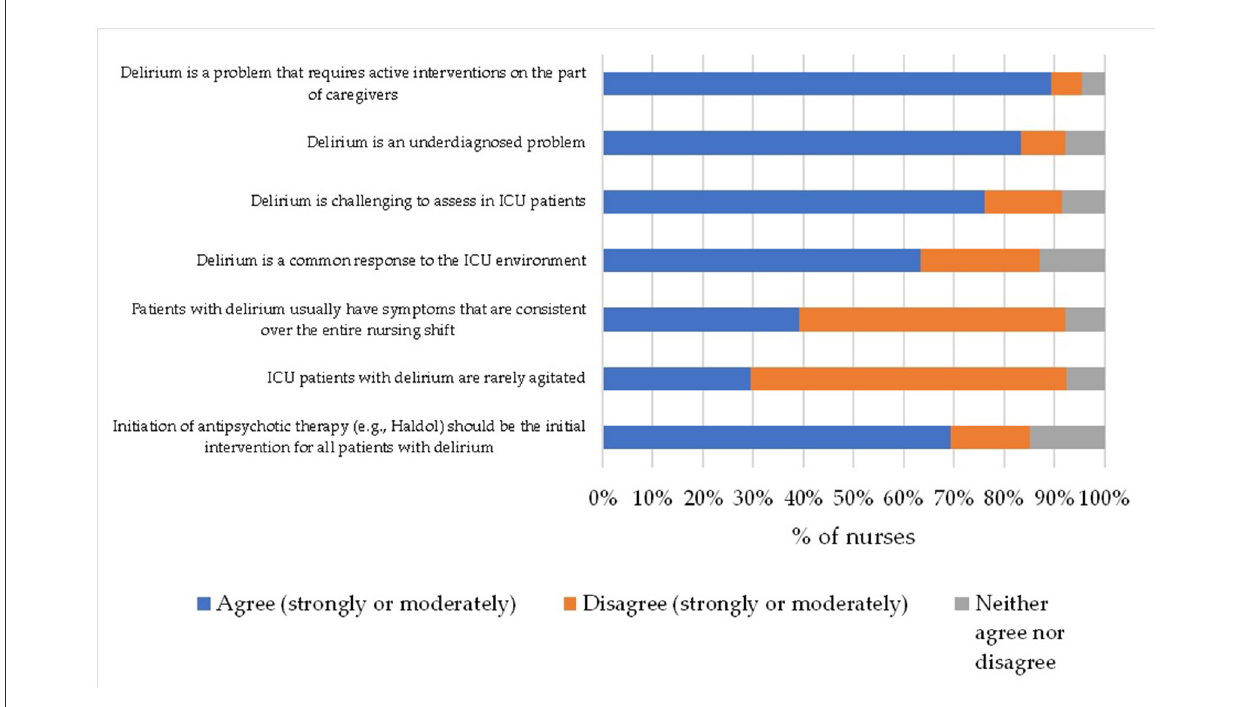
FIGURE1 ICU nurses’ perception of